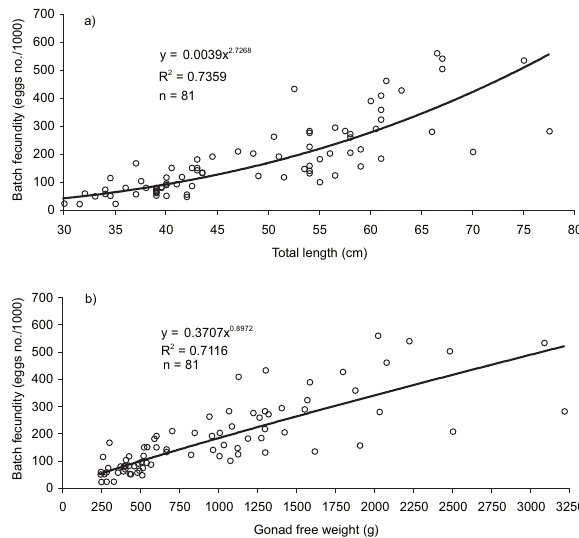
Fig . 12. – Northern Tyrrhenian Sea. Relationships between batch fecundity (eggs number/female) and a) total length (cm); b) female gonad-free weight (g). Number of females =